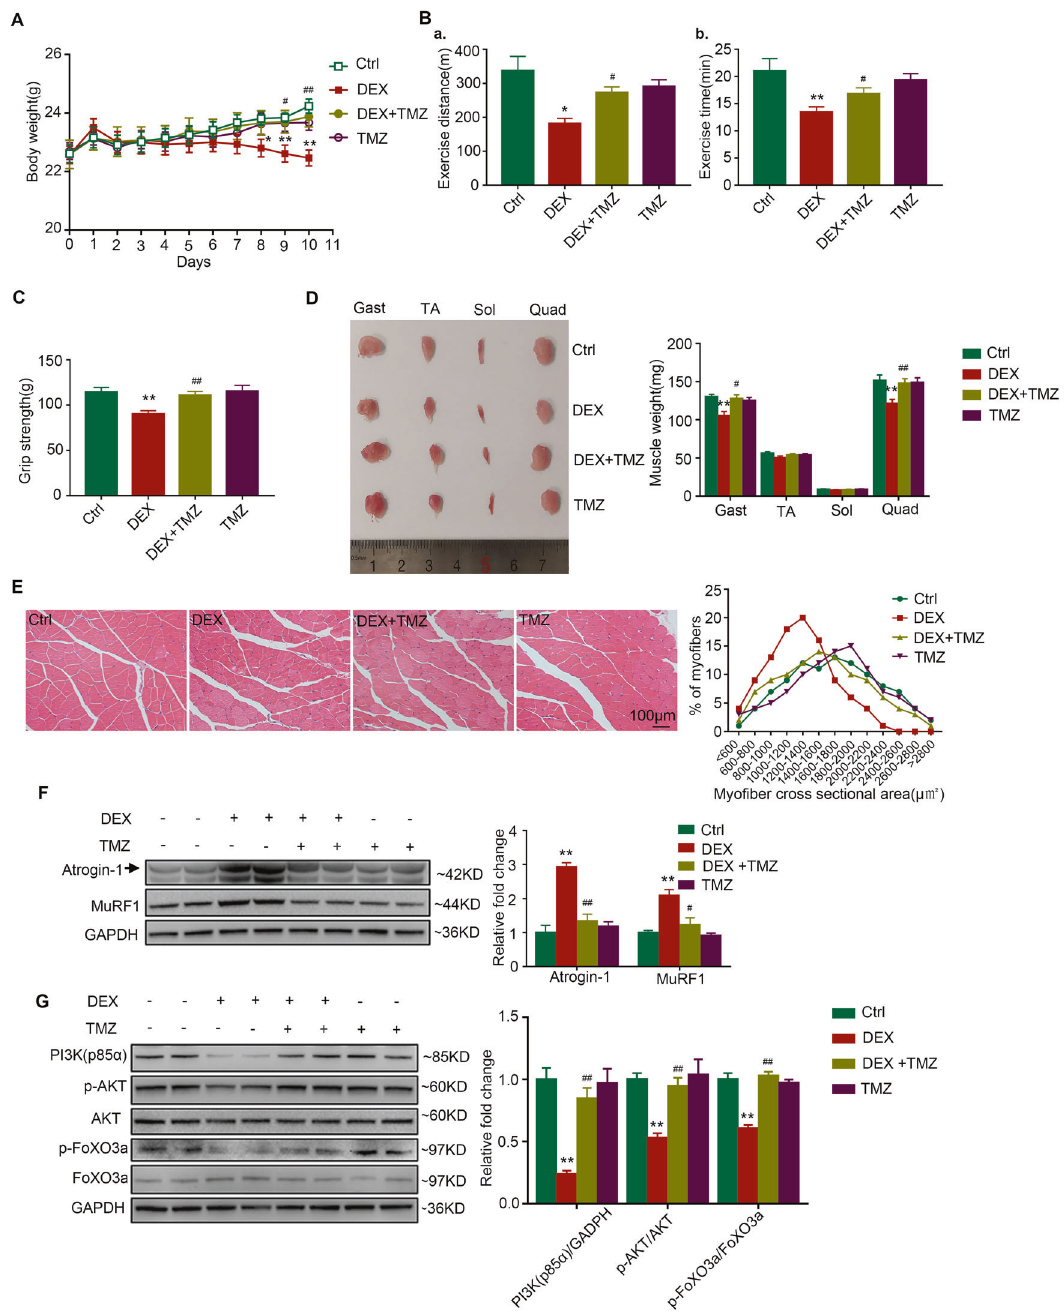
Fig. 4 TMZ ameliorates DEX-induced muscle atrophy in mice. Mice were intraperitoneally injected with 0.9% saline (Ctrl), DEX (25 mg/kg), TMZ (5 mg/kg), or DEX (25 mg/kg) + TMZ (5 mg/kg) for 10 days. A Body weight of mice. n = 8 per group. B Exercise capacity testing. a. Running distance. b. Running time. n = 8 per group. C Grip strength test. n = 8 per group. D Comparison of representative samples of dissected skeletal muscle including gastrocnemius (Gast), tibialis anterior muscle (TA), soleus muscle (Sol), and quadriceps (Quad). n = 4 per group. E Representative H&E staining of myo fi ber cross-section of Gast. Scale bar = 100 μ m. A microscope with a 10× objective was used to capture the images. n = 4 per group. F Protein levels of Atrogin-1 and MuRF1 in Gast muscle. n = 4 per group. G Protein levels of p85 α PI3K, p-AKT, total AKT, p-FOXO3a, and total FOXO3a in Gast muscle. n = 4 per group. * P < 0.05 vs. Ctrl. ** P < 0.01 vs. Ctrl. # P < 0.05 vs. DEX. ## P < 0.01 vs. DEX. DEX dexamethasone, TMZ trimetazidine, Ctrl control. treated C2C12 myotubes (Fig. 6C). As expected, PPP treatment were treated with a PI3K/AKT pathway inhibitor, picropodophyllin almost blocked the effects of trimetazidine on the inhibition of (PPP), together with trimetazidine. When co-treated with PPP, the dexamethasone-induced upregulation of Atrogin-1 and MuRF1 (Fig. phosphorylation of PI3K, AKT, and FoxO3a in trimetazidine-treated 6C). Therefore, these data suggest that trimetazidine mitigated myotubes were almost abolished (Fig. 6B). Furthermore, co- dexamethasone-induced pyroptosis and atrophy in C2C12 myotubes treatment of PPP diminished the inhibitive effects of trimetazidine via activating PI3K/AKT pathway. on NLRP3, cleavage of Caspase-1, and GSDMD in dexamethasone-